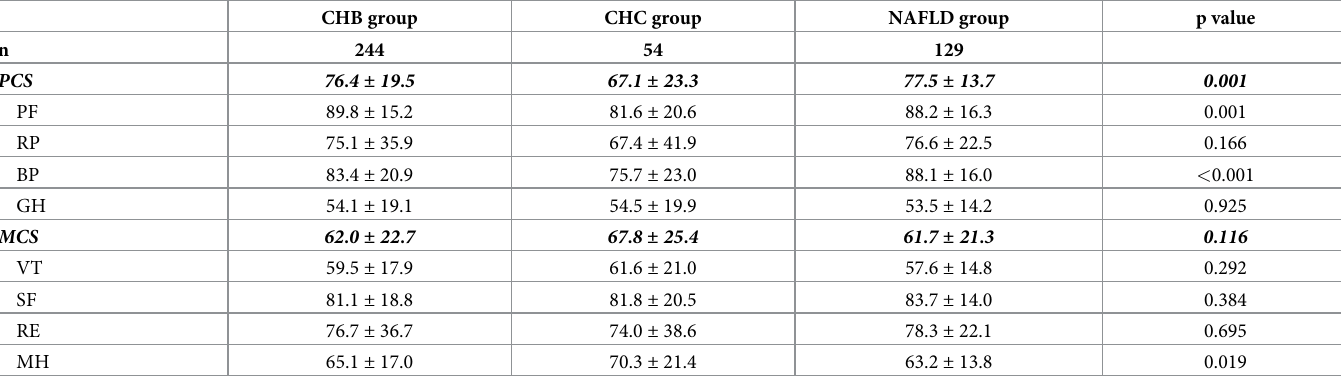
Table 2. Comparison of SF-36 scores between CHB, CHC and NAFLD patient